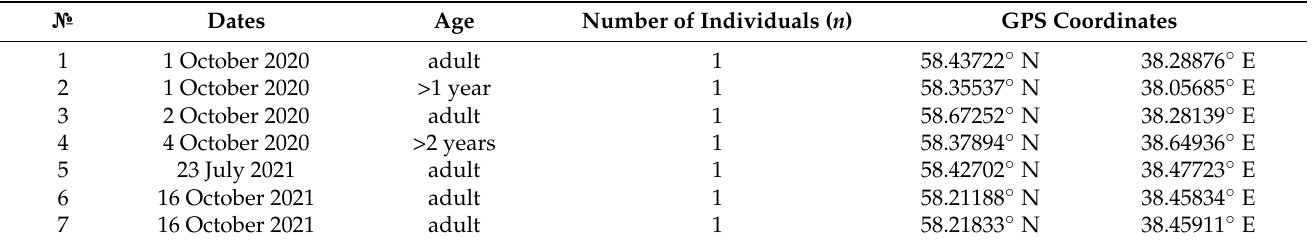
Figure 2. The Pallas’s Gulls ( Ichthyaetus ichthyaetus ) of different ages: ( a )—adult in winter plumage eating Bream ( Abramis brama ). 17 September 2022, Kuibyshev reservoir; ( b )—juvenile individual molting into first-winter plumage. 17 September 2022, Kuibyshev reservoir; ( c )—individual in plumage of the second winter. 23 September 2020, Gorky reservoir; ( d )—individual in plumage of the third winter. 15 September 2020, Saratov reservoir; ( e )—individual in plumage of the third winter. 4 October 2020, Rybinsk reservoir; ( f )—adult in summer plumage molting into winter plumage. 17 September 2022, Kuibyshev reservoir. Images: S. V. Golubev. In 2020–2022, the proportion of juveniles was 16.6%, and 83.4% included adults in Table 5. Records of the Pallas’s Gulls ( Ichthyaetus ichthyaetus ) at the Rybinsk reservoir,